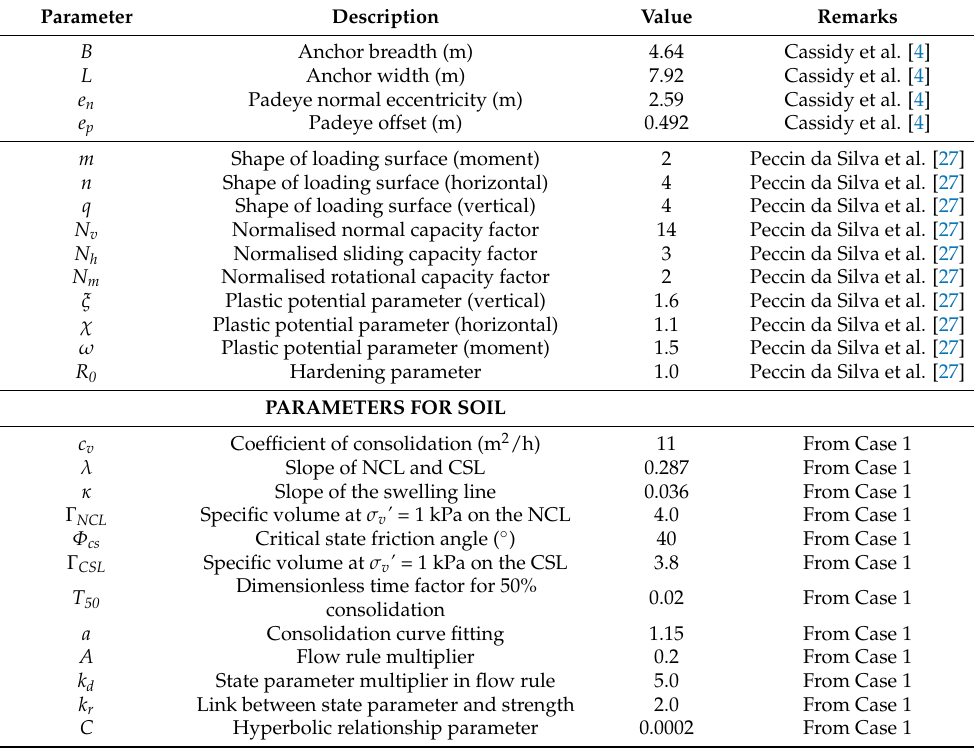
Table 2. Geometry and modelling parameters for the anchor